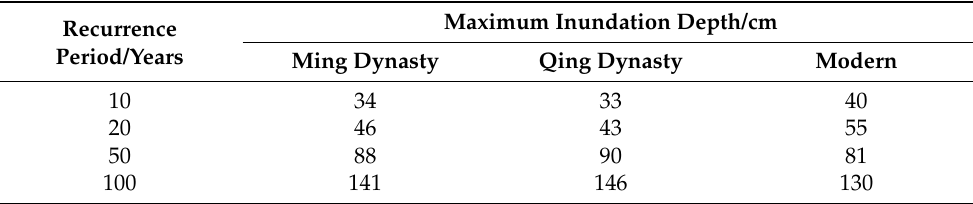
Table 8. Maximum inundation depth under different recurrence periods and land-use scenarios.